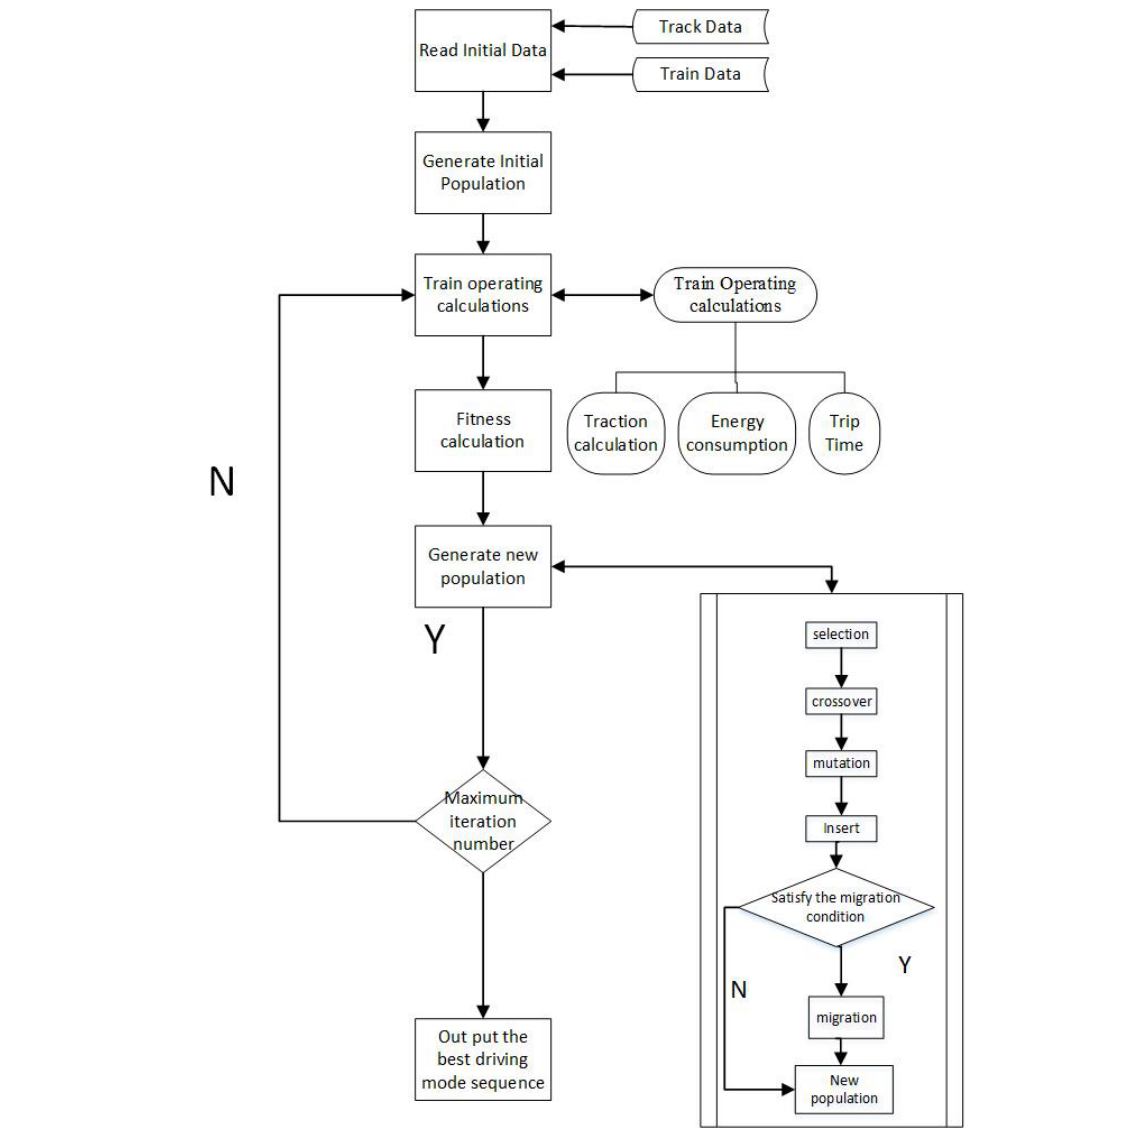
Figure 6. Algorithm flowchart for the multi-population genetic algorithm